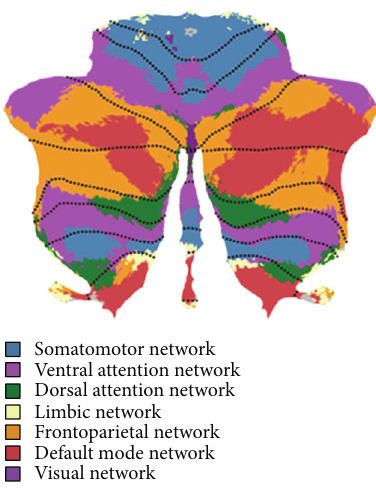
Figure 2: A map of the human cerebellum based on functional connectivity to seven major networks in the cerebrum.